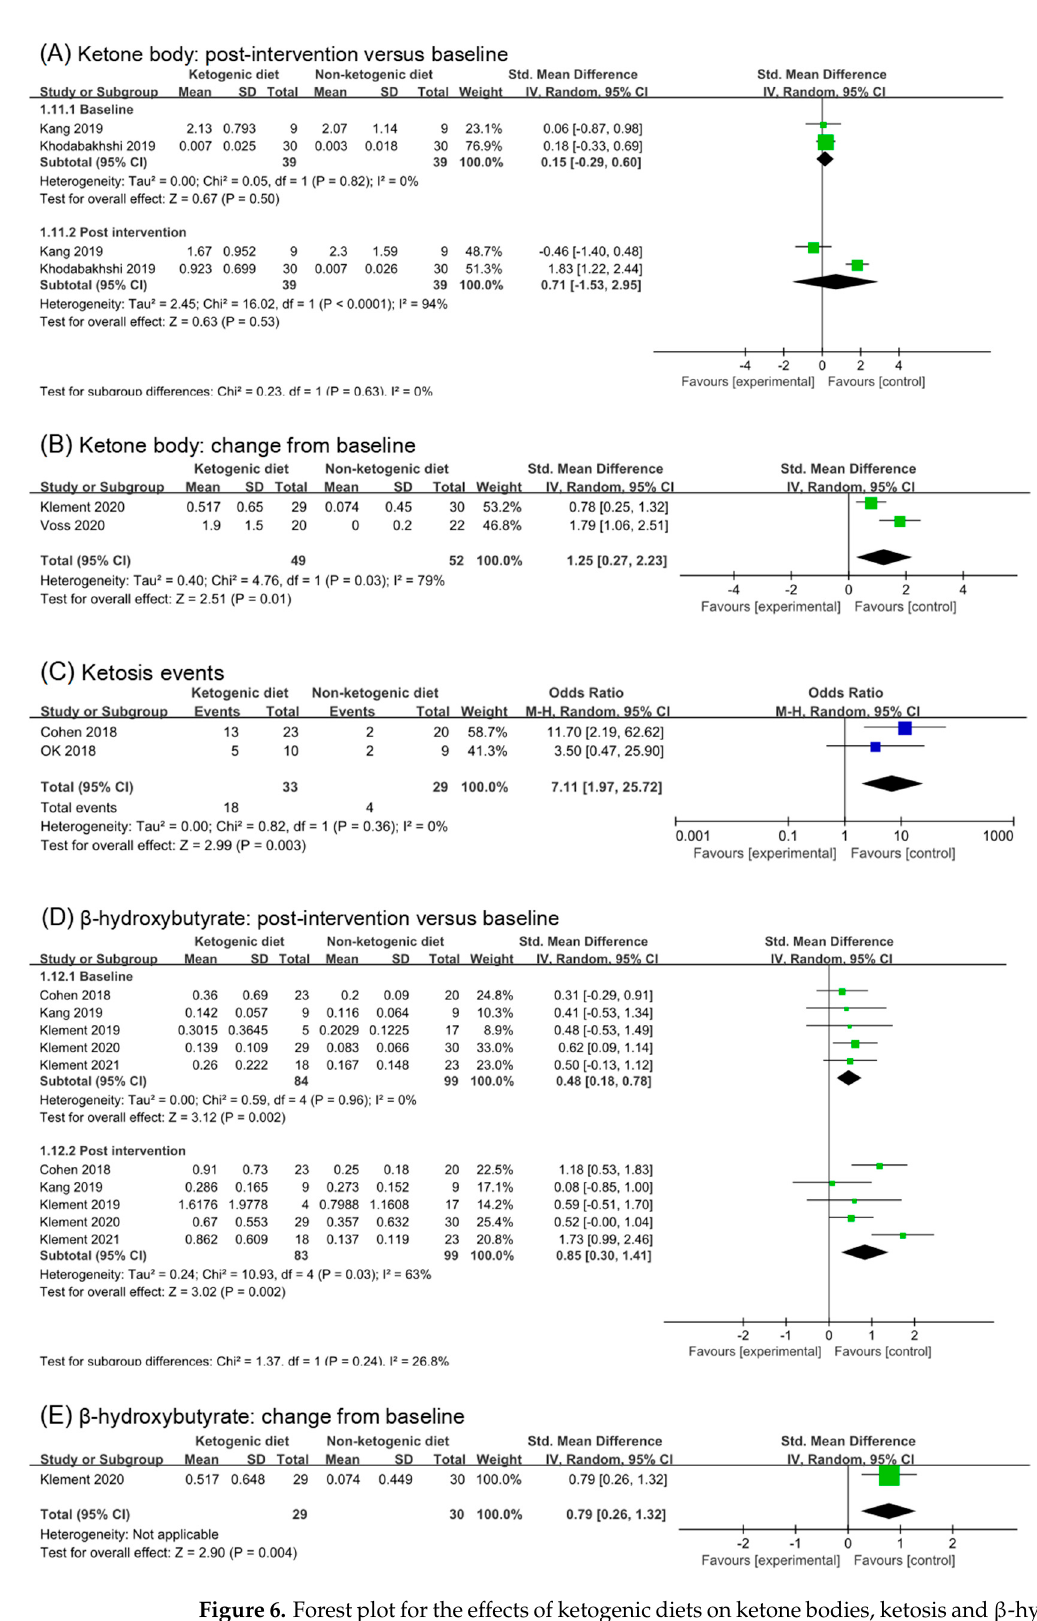
Figure 6. Forest plot for the effects of ketogenic diets on ketone bodies, ketosis and β -hydroxybutyrate. ( A , B ) were subgroup effects of the baseline versus post-intervention and effects of change from baseline on ketone body; ( D , E ) were ones on β -hydroxybutyrate; ( C ) was risk ratio for ketosis in comparison of ketogenic group and control group [26–39,41,42].